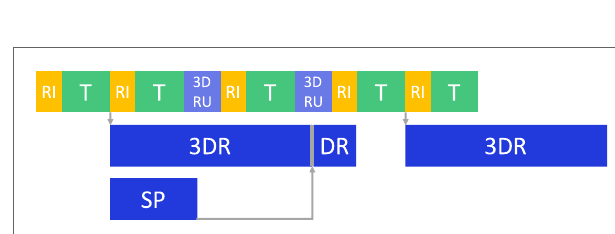
FigUre 9 | Optimization pipeline . Multithreading was used to improve the computational time: after the images are read (RI), tissue tracking (T), 3D reconstruction and disparity refinement (3DR and DR) are run in separate threads. If 3DR is not completed, an updated version of the old point cloud (3DRU), based on the 2D tracking motion, is used. Super pixel segmentation (SP) is also run in a separate thread.